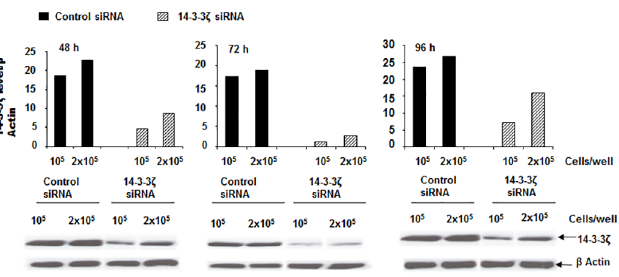
Fig 4. siRNA knockdown of 14-3-3 ζ expression in HEK 293 cells. A time dependent plot of levels of 14-3- 3 ζ expression following siRNA knockdown of the 14-3-3 ζ in HEK 293 cells. Cells were seeded at either 1.0 or 2.0 x10 6 cells/well in 6-well culture dishes. For 14-3-3 ζ targeting, three independent Stealth RNA duplex primers (Life Technologies) were pooled and used at a final concentration of 100 nM. Residual 14-3-3 ζ expression levels were determined at 48, 72 and 96 h post transfection. Beneath the plots are Western blots showing the extent of 14-3-3 ζ depletion (optimal at 72 h) at 1.0 x 10 6 cells/well.